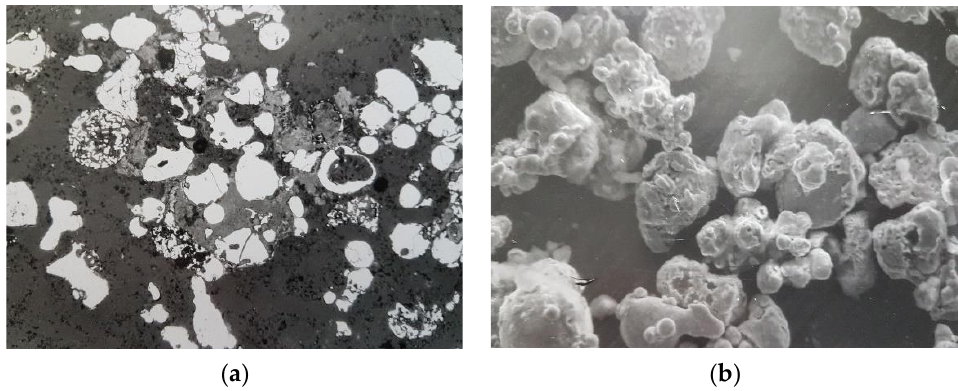
Figure 11. Microstructure of powder from steel 50 after mechanical grinding ( a ); obtained by melt spraying ( b ).